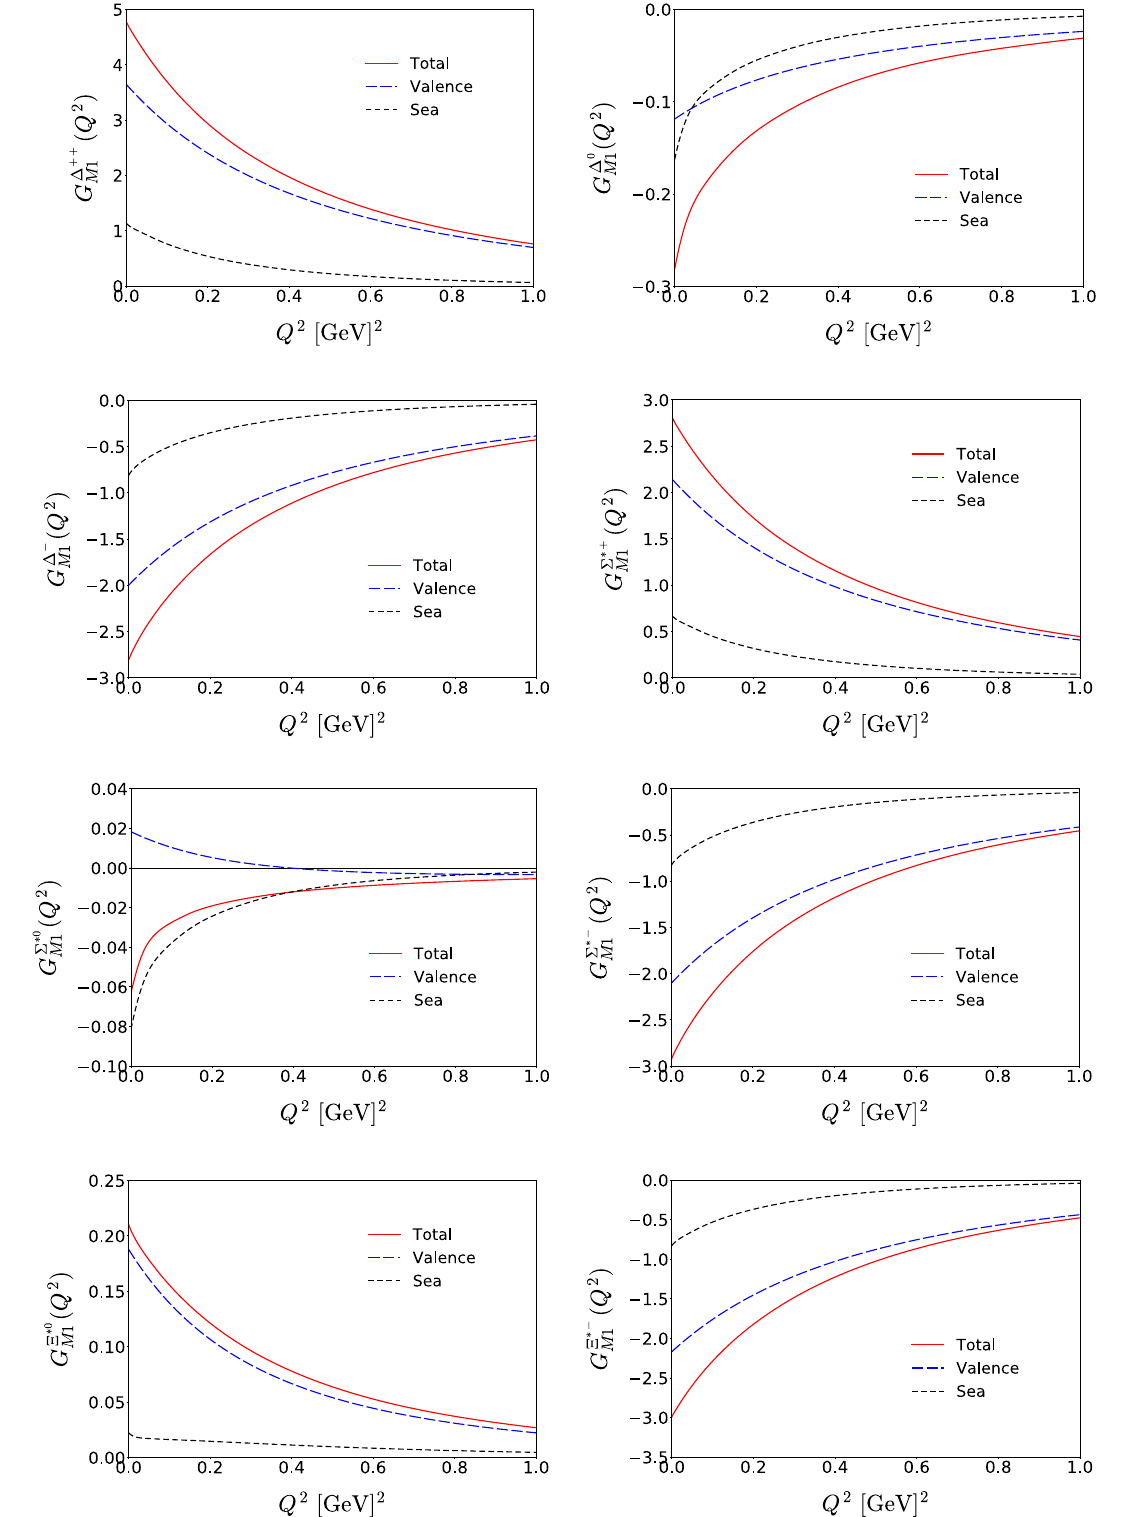
Fig. 4 Sea and valence contributions to the magnetic dipole form factors of the other members of the baryon decuplet except for the (cid:2) + and (cid:5) − baryons. Notations are the same as in Fig.